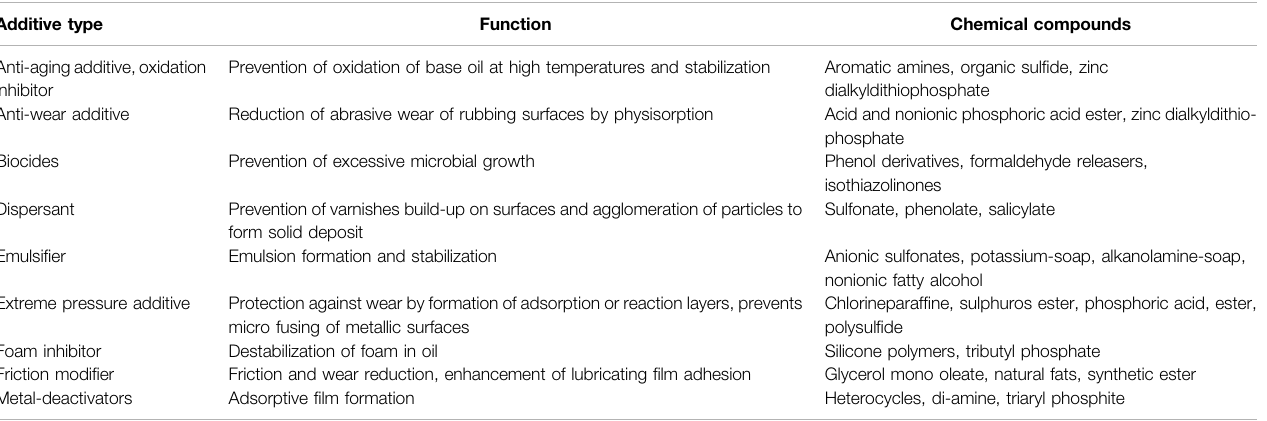
TABLE 11 | Additives related to